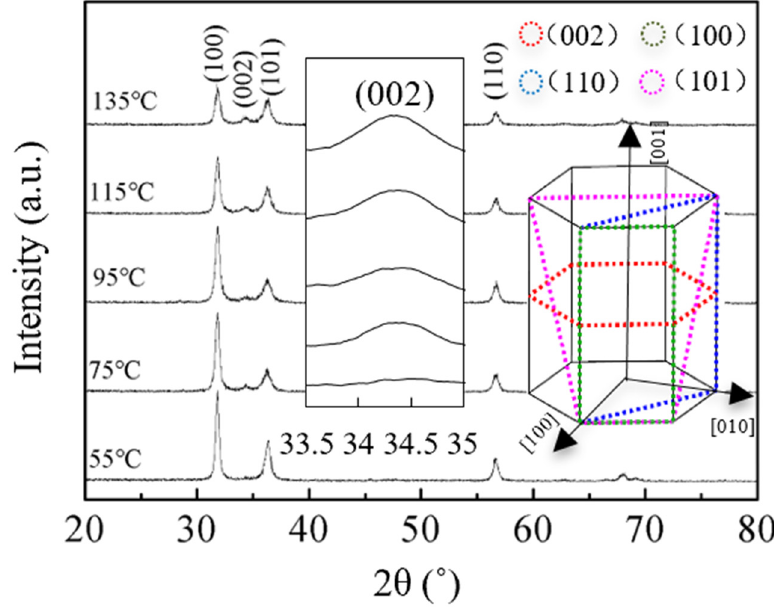
Figure 6. Grazing-incidence X-ray di ff raction patterns of sALD-ZnO films deposited at di ff erent temperatures.